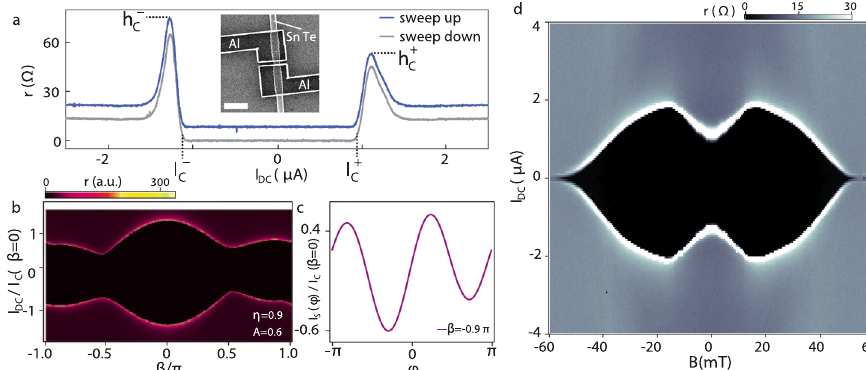
Fig. 1 The DC Josephson effect. a Differential resistance r as a function of DC bias current I DC in different sweep directions. The bias sweeps show no hysteresis and two nonidentical critical currents and peak heights h þ consisting of two aluminum (Al) superconductors coupled via a SnTe nanowire. White scale bar is 1 μ m. b The simulated differential resistance β ) calculated by the resistively shunted junction model, where the best fi t of parameters ( A , β ) are (0.6 − 0.9 π ). The resulting CPR is plotted r ( I DC , in c . d The magnetic diffraction pattern r ( I DC , B ), showing a critical current minimum at B = 0.